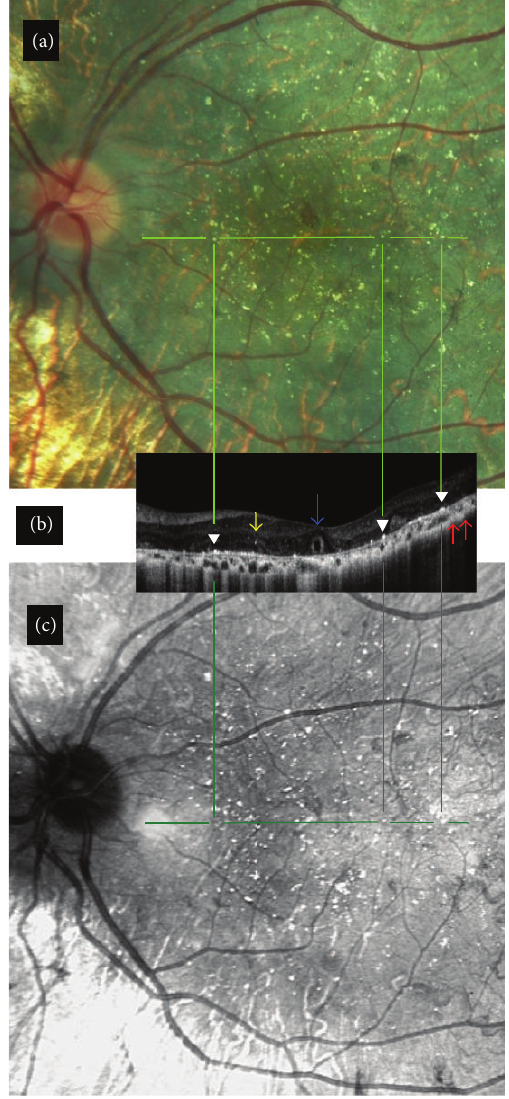
Figure1:Case3,lefteye.(b)TransversSD-OCTsection.Bluearrow: outer retinal tubulations alone or with high reflective spots within. White arrowheads: bright reflective spots on top of RPE-Bruch membrane complex. Yellow arrow: intraretinal hyperreflective dot. Redarrows:choroidalhyperreflectivespots.(a)and(c)Colorfundus andreflectanceimagesandtherelationshipbetweenbrightreflective spots on top of RPE-Bruch membrane complex and crystals.